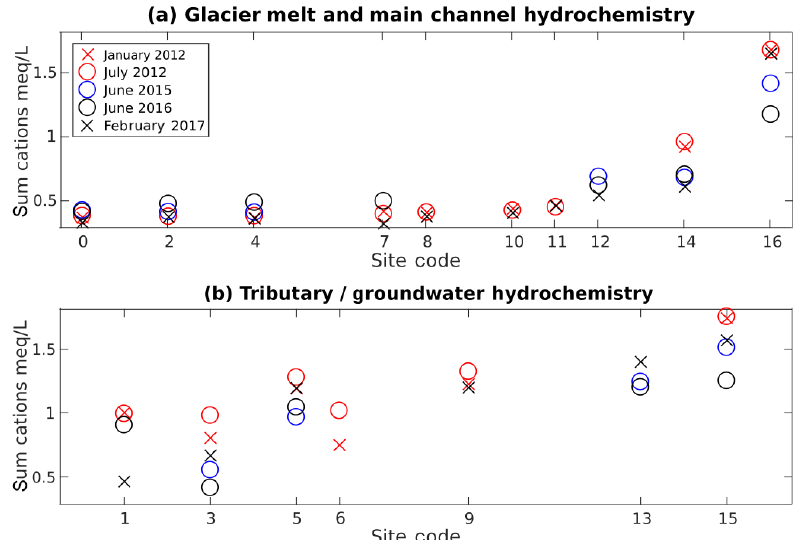
Figure 3. (a) Hydrochemistry at different sampling locations along the Gavilan Machay main channel shows variability in space and over the five sampling periods; site codes are ordered from highest (0 for meltwater) to lowest (16 for Boca Toma) elevation (see Fig. 1b). (b) Hydrochemistry for different tributary (sites 3, 6, 9, and 15) and groundwater (spring) samples (sites 5 and 13), ordered from highest to lowest elevation, shows variability in space and time.